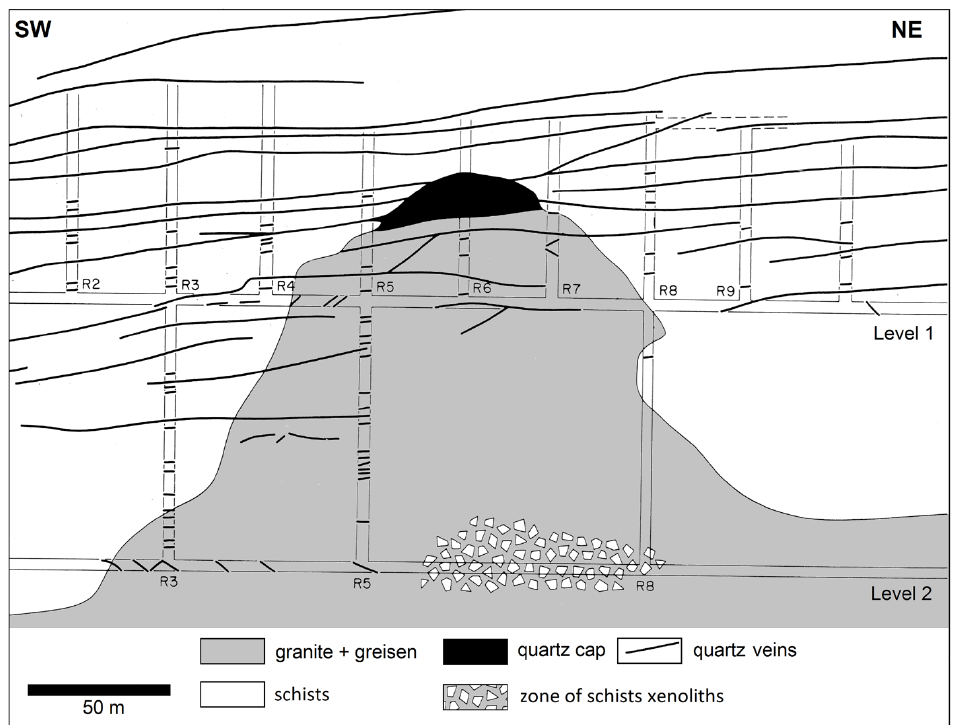
Figure 2. A simplified cross-section through the Panasqueira cupola along Panel 4. Vertical and lateral scales are the same. The Rx labels refer to vertical mining workings. Levels 1 and 2 are positioned 620 and 530 m above sea level, respectively. Modified from [1,4].